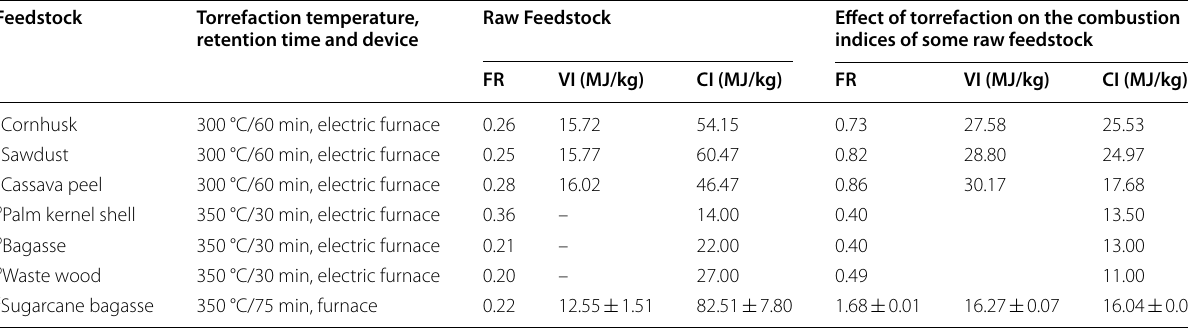
FR fuel ratio, CI combustibility index, VI volatile ignitability a Akogun and Waheed (2022) b Ohm et al.